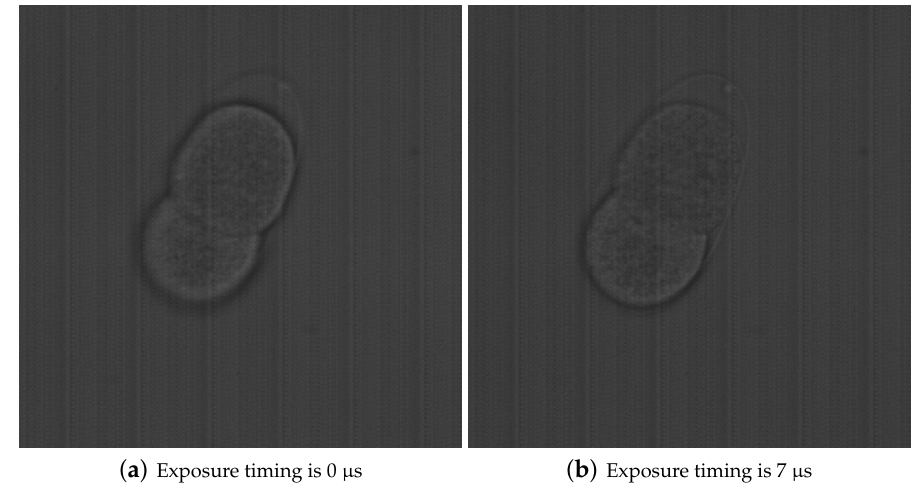
Figure 9. Measured images of two-celled embryo of C. elegans by experimental system. The microscope used by this measurement was IX71 (Olympus). The objective lens was UPLANSAPO 60XS2 NA1.3 (Olympus). These images were acquired by bright field observation.